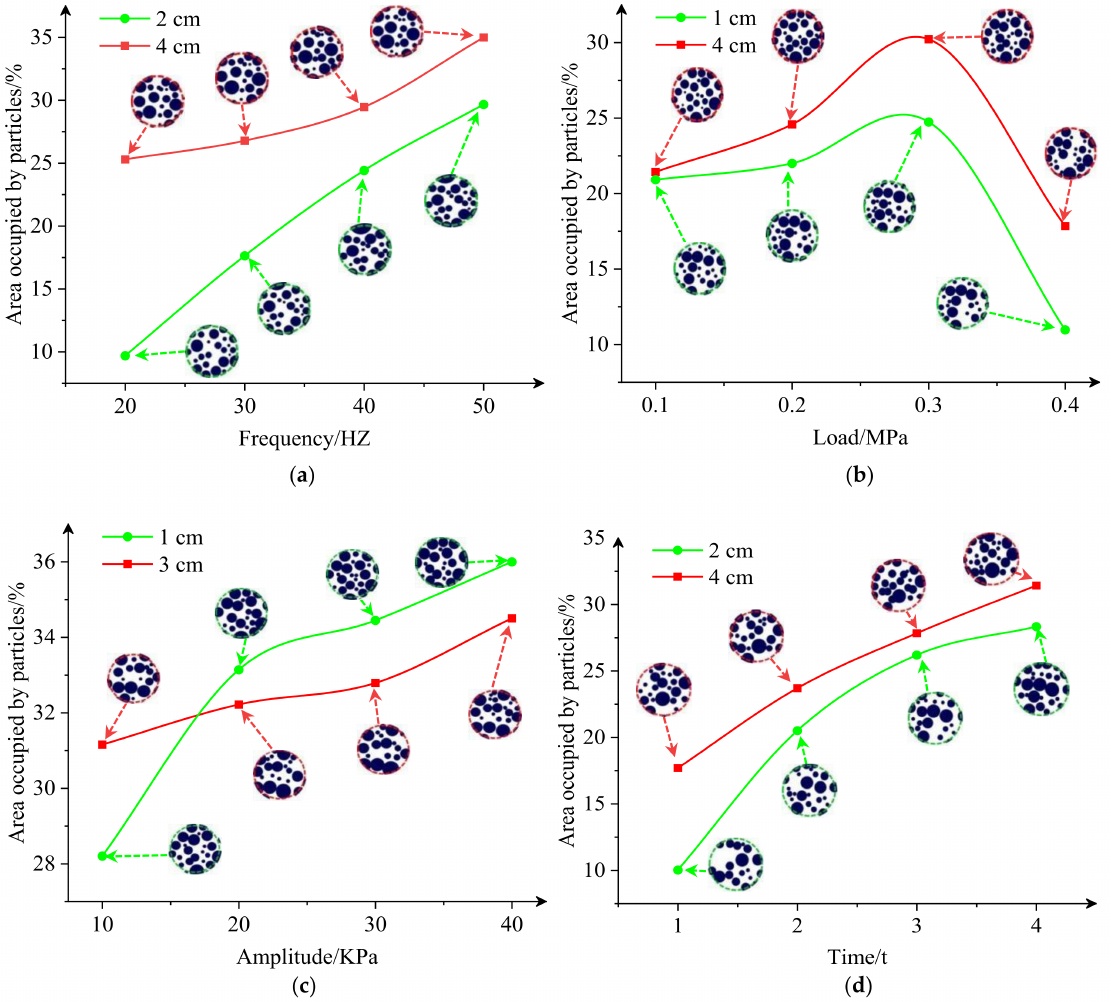
Figure 13. Particle movement and variation; ( a ) Particle area varies with frequency (x-axis shows the frequency, y-axis shows the change in particle area); ( b ) Particle area varies with excitation